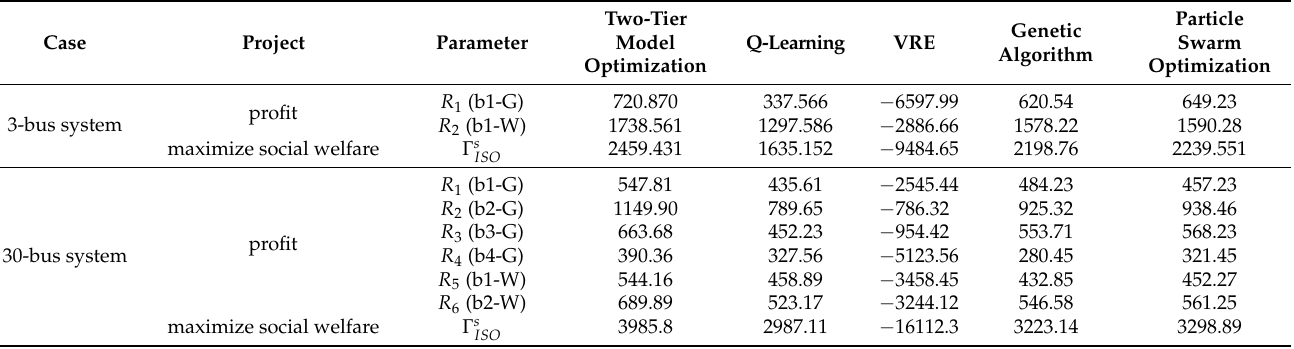
Table 6. Comparison of the benefits of different